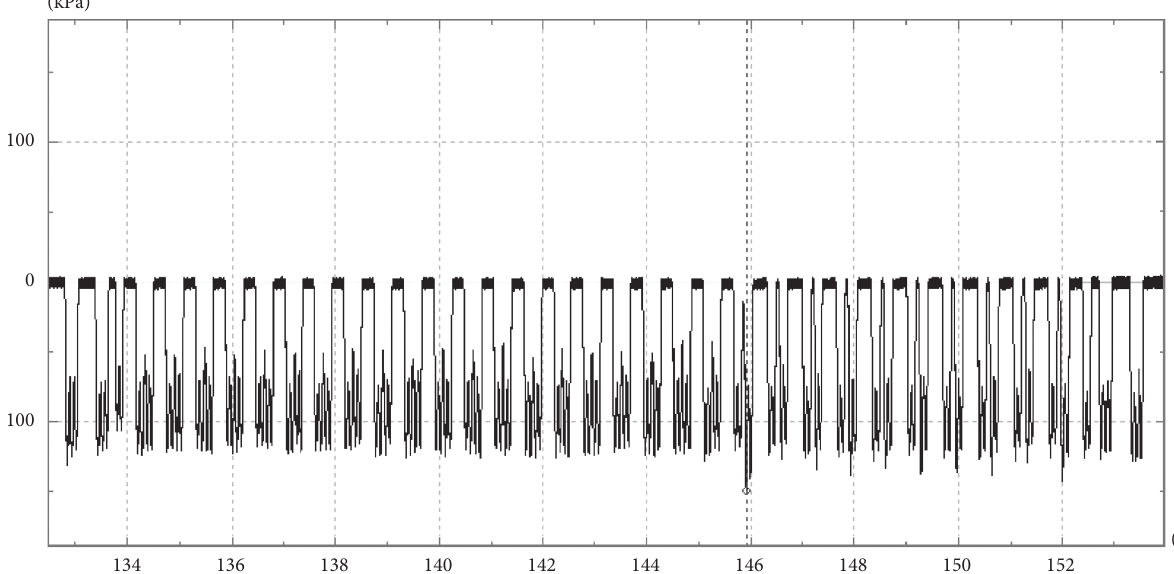
Figure 12: Vertical dynamic stress of the top surface of invert filling layer under the track in the intact